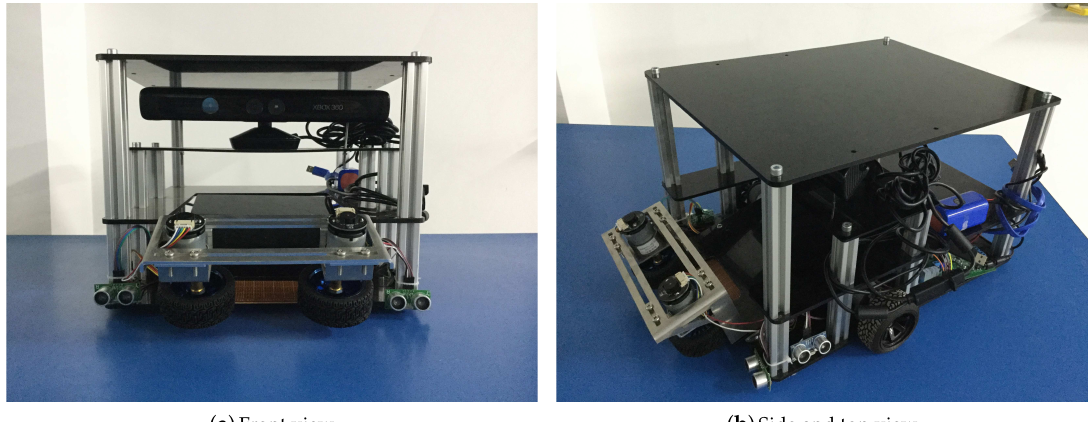
Figure 2. Photos of our tennis robot from different